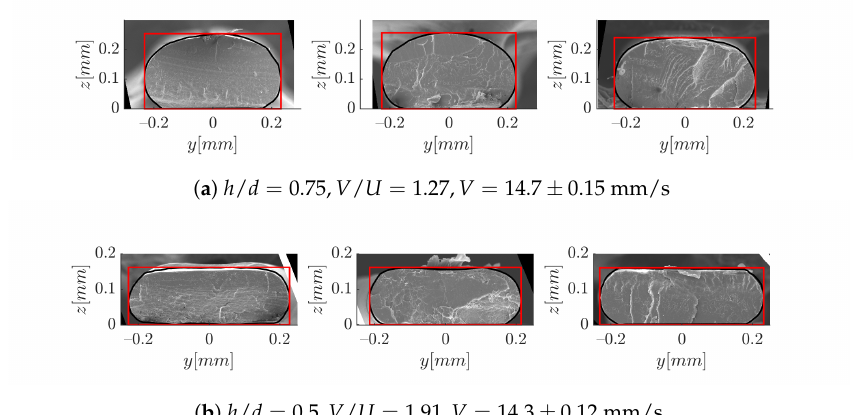
Figure 18. Illustration of the repetability of strand deposition.